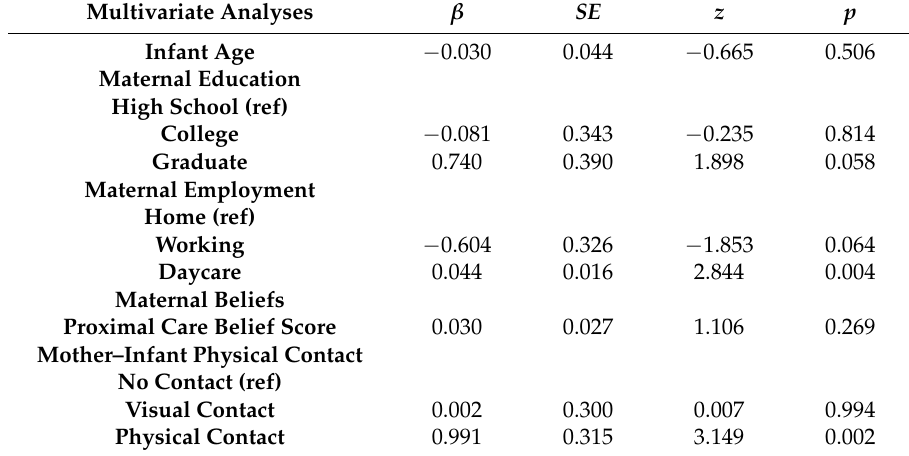
Table 6. Model Predicting Responsiveness to Cues. Fixed effects for the mixed-effects model predicting initiating hunger-related feedings in response to early cues (in comparison with crying) in Study 2.